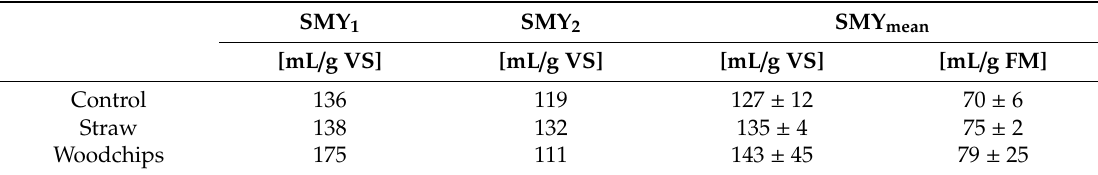
Table 4. Specific methane yield (SMY) of chicken manure with and without additives measured in dry batch anerobic digestion